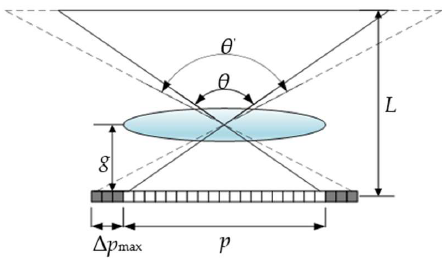
Figure 5. FOV extension for the lens.